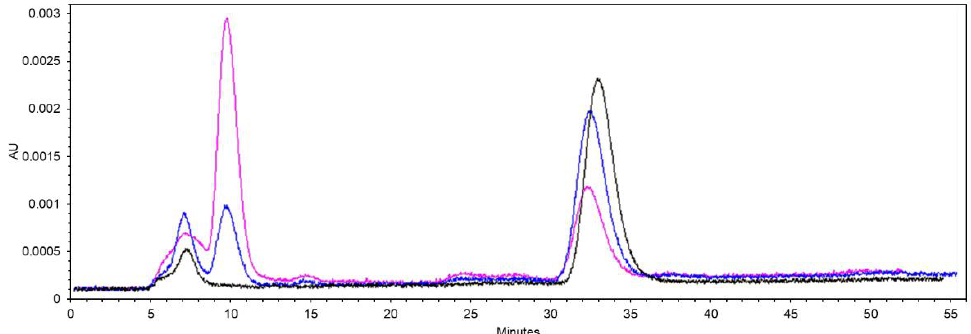
Figure 8. Example of the trend of the HPLC spectra measured at 280 nm, at different times of reaction: t = 0 (black curve), t = 60 min (blue curve), and t = 300 min (pink curve).